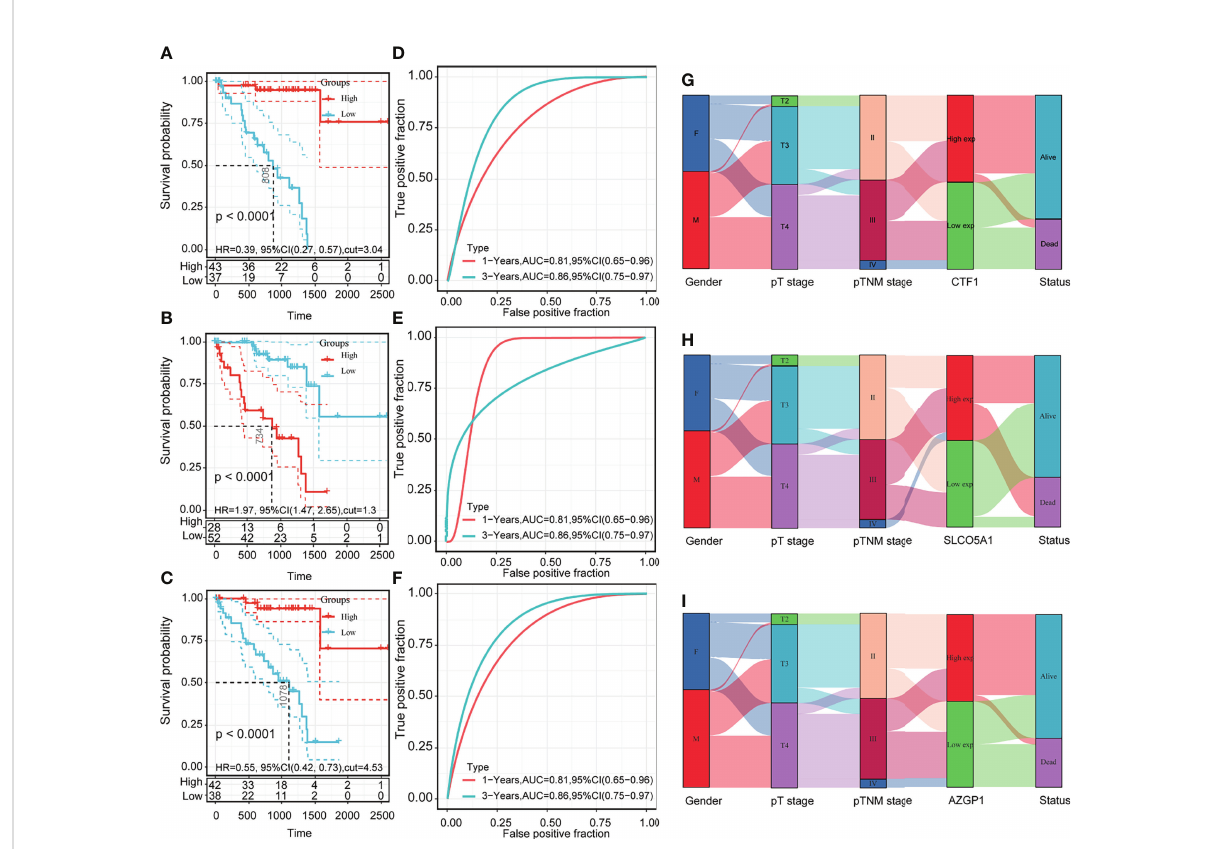
FIGURE 5 Prognosis of core genes, clinical characteristics, and model accuracy analysis. (A – C) KM survival curves of high and low expressions of AZGP1, SLCO5A1, and CTF1; (D – F) 1-year and 3-year ROC curves of high and low expressions of AZGP1, SLCO5A1, and CTF1; (G – I) Sankey plots of high and low expressions of AZGP1, SLCO5A1, and CTF1 with clinical characteristics; statistically signi fi cant at p < 0.05.